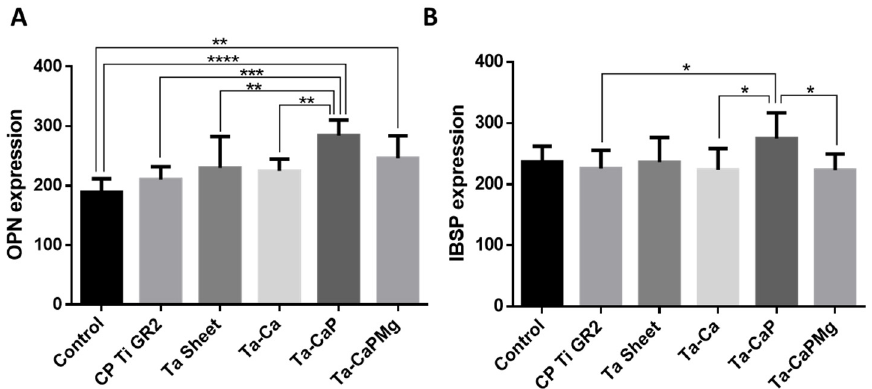
Figure 20. Graphs show ( A ) OPN quantification and ( B ) IBSP quantification represented as mean ± standard deviation. Significant values as **** p < 0.0001, *** p < 0.001, ** p < 0.01, * p > 0.05. Adapted with permission from Ref. [73]. Copyright 2021 Elsevier.